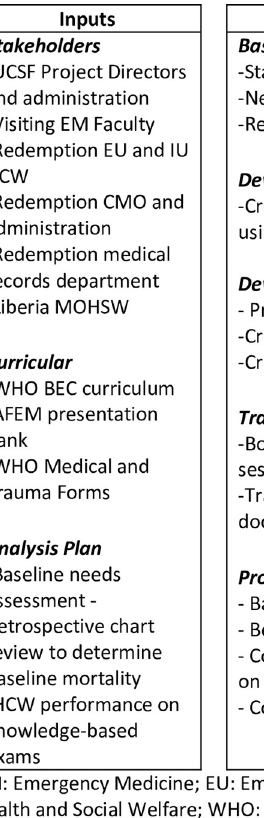
Fig 1. Implementation research logic